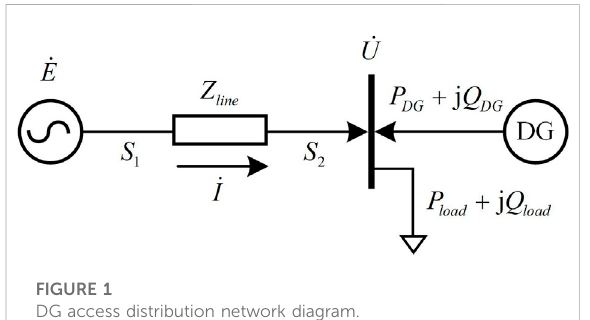
FIGURE 1 DG access distribution network diagram.